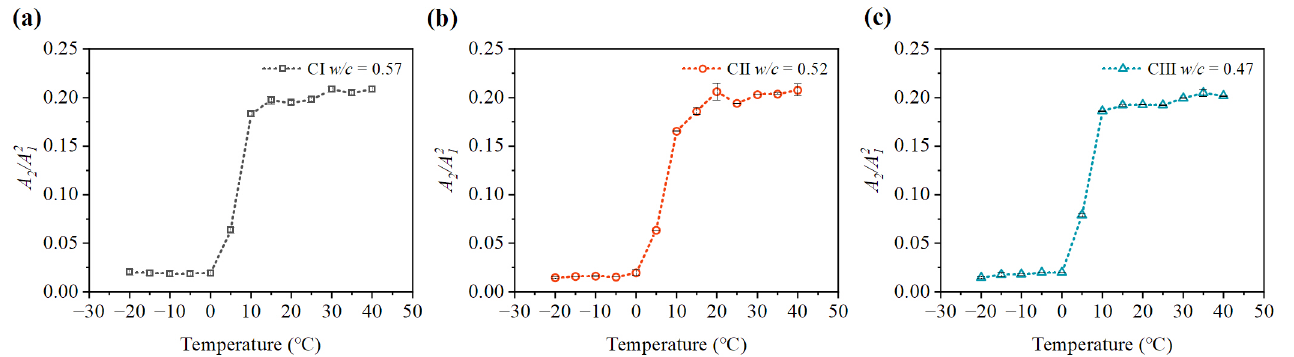
at different temperatures (day 3): ( a ) nonlinear 1 of CII; ( c ) nonlinear parameter A 2 / A 2 1